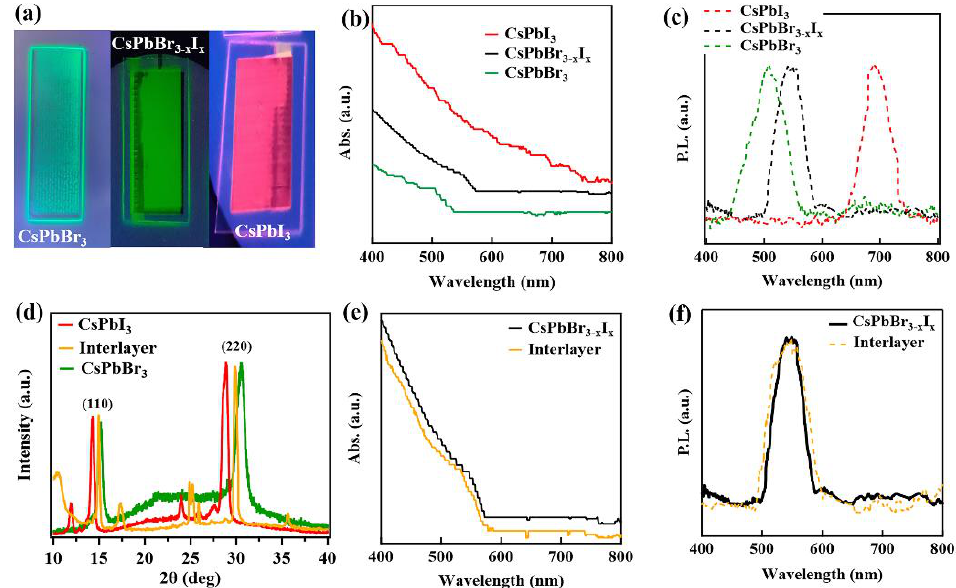
Figure 3. ( a ) image of printed films under UV light, ( b ) optical absorption spectra obtained for printed films of CsPbBr 3 , CsPbI 3 and alloyed CsPbBr 3 − x I x ., ( c ) PL spectra for printed films of CsPbBr 3 , CsPbI 3 and alloyed CsPbBr 3 − x I x. ( d ) the XRD spectra CsPbBr 3 and CsPbI 3 single-layer printed films, compared to the inter-layer printed film ( e ) the optical absorption spectra and ( f ) PL spectra of alloyed CsPbBr 3 − x I x perovskite single-layer printed film, compared to the inter-layer printed film (denoted interlayer).